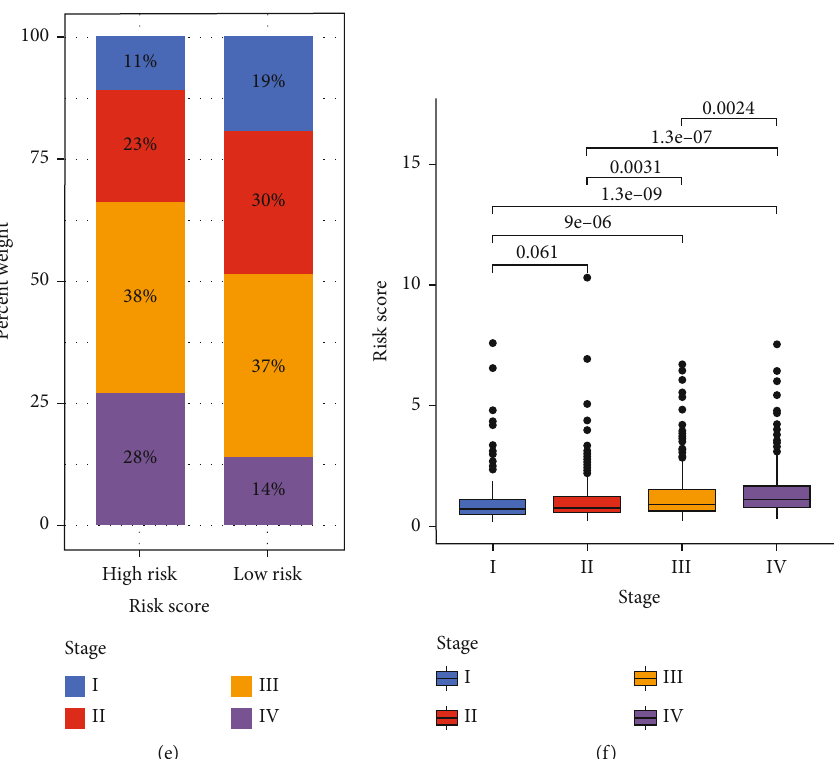
Figure 7: The correlation analysis between the risk score and clinical characteristics. (a) The Kaplan – Meier survival analysis regarding Lauren classi fi cation and OS. (b) Barplot of proportions of di ff erent Lauren classi fi cation subtypes in high- and low-risk groups. (c) Boxplot of the risk score di ff erence in di ff erent Lauren classi fi cation subtypes. (d) Kaplan – Meier survival analysis regarding stage and OS. (e) Barplot of proportions of di ff erent stages in high- and low-risk groups. (f) Boxplot of the risk score di ff erence in di ff erent